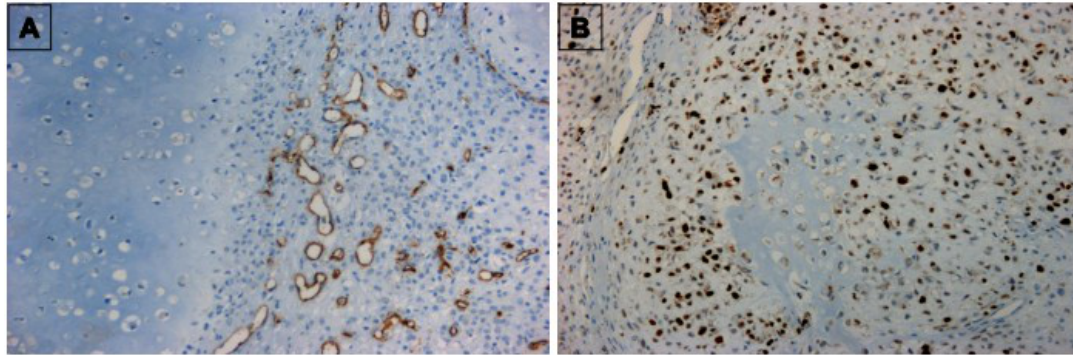
Figure 1. Immunohistochemistry of bone sarcomas. ( A ) CD31-immunostained chondrosarcoma specimen (TEC 1 line); ( B ) ki67-stained chondrosarcoma specimen; ( C ) CD31-stained osteosarcoma specimen (TEC 2 line); ( D ) Ki67-stained osteosarcoma